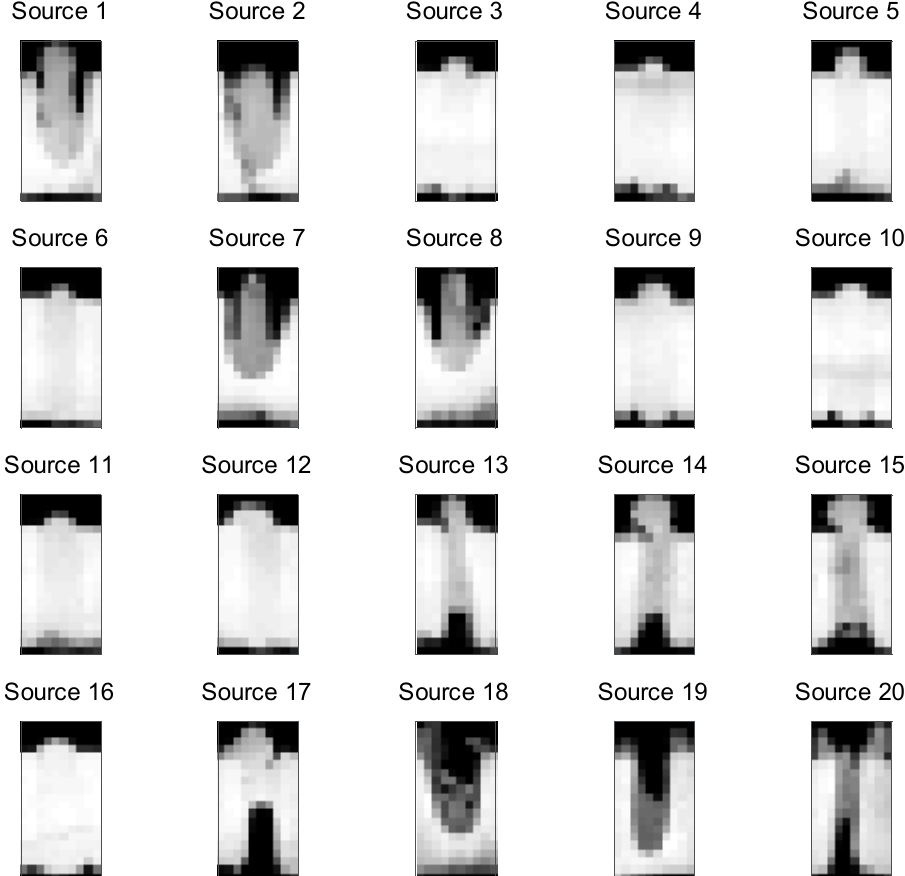
Figure 1. A corpus of 20 weld images which have been destructively sampled.